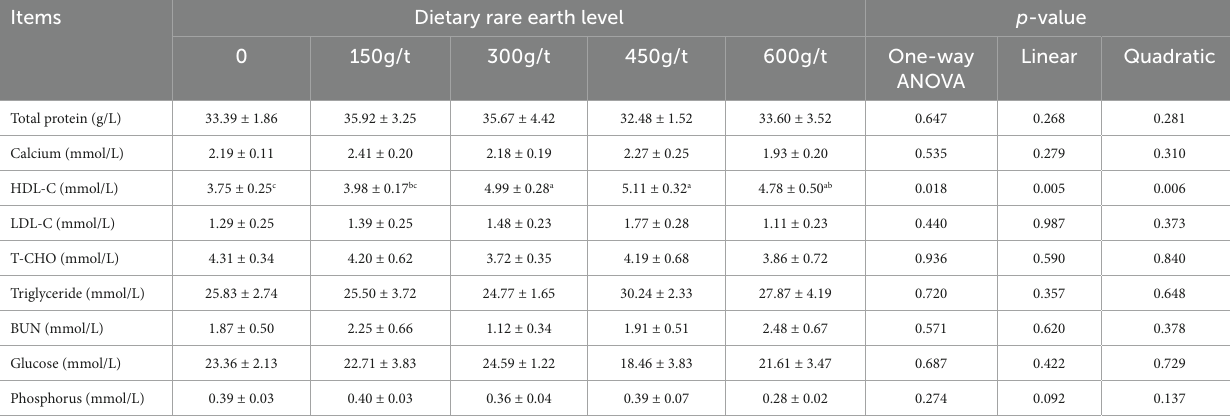
TABLE 4 Effects of dietary rare earth supplementation on serum biochemical parameters in laying hens during the late laying stage ( n = 6).